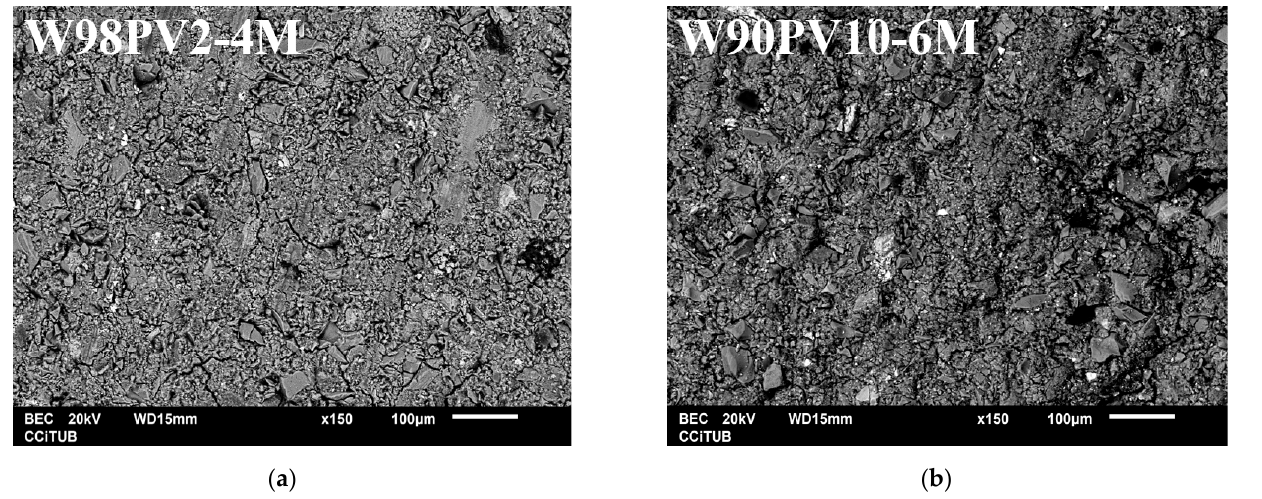
Figure 8. SEM images of ( a ) W98PV2-4M sample and ( b ) W90PV10-6M sample.